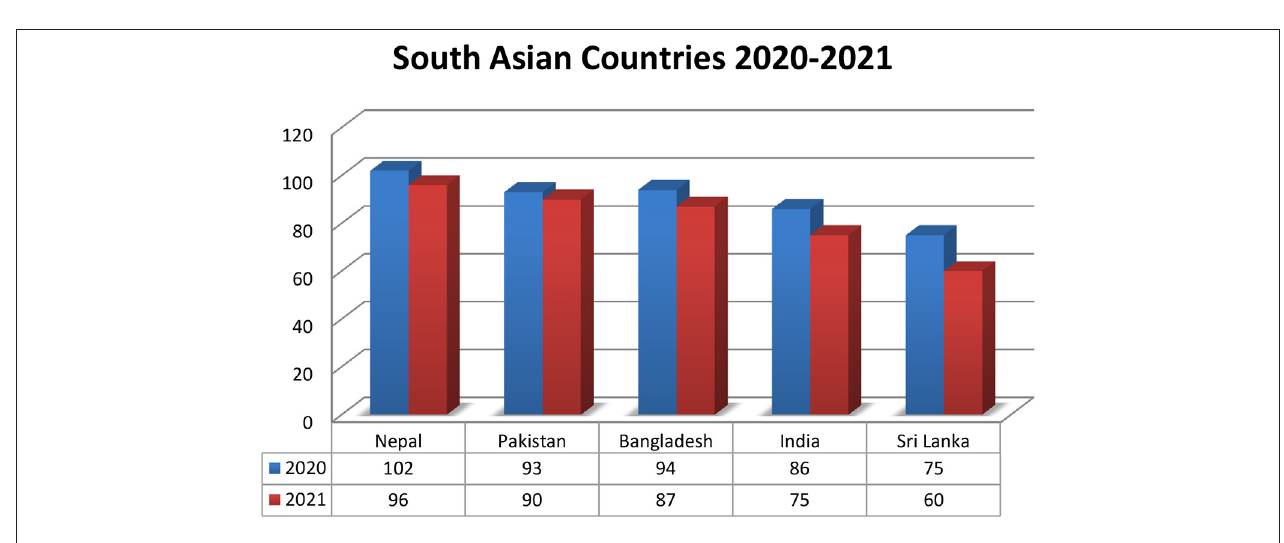
FIGURE 5 | Countries year-wise comparision (2020–2021).